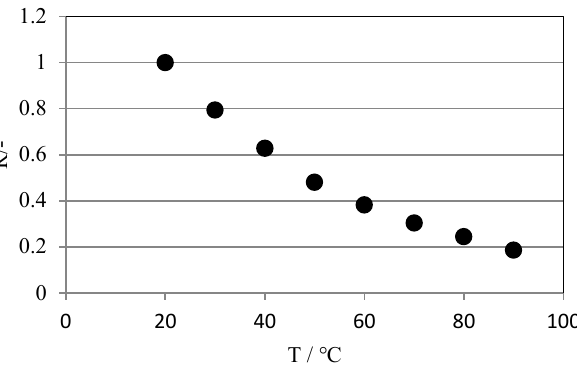
Figure 1. Relationship between the brightness ratio of rhodium B and temperature.